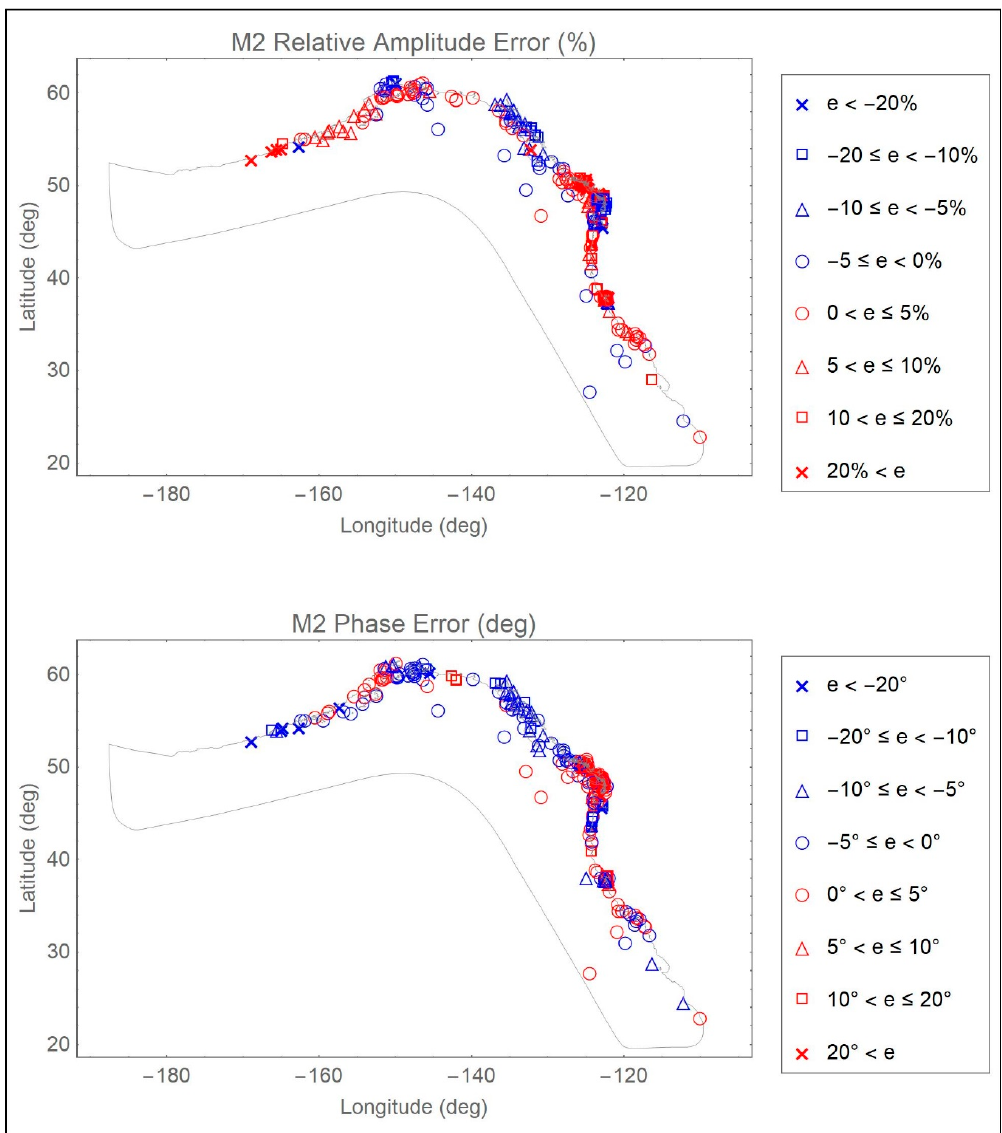
Figure 10. Relative amplitude (%) and absolute phase errors (deg) in the M 2 constituent at each of the 258 global validation stations for the ENPAC15 database. Zoomed views are provided in Appendix D.